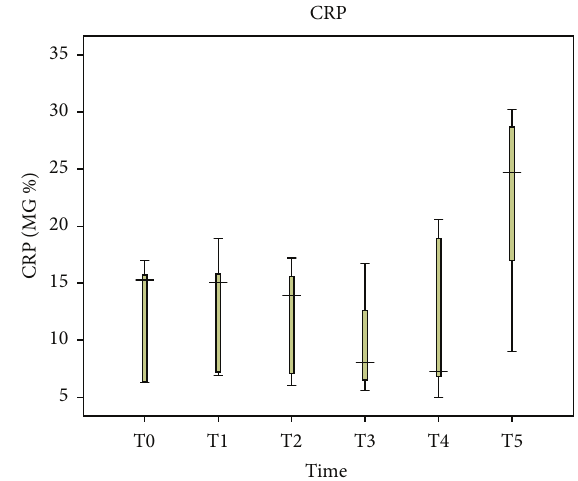
Figure 4: Perioperative C-reactive protein (CRP) levels in blood